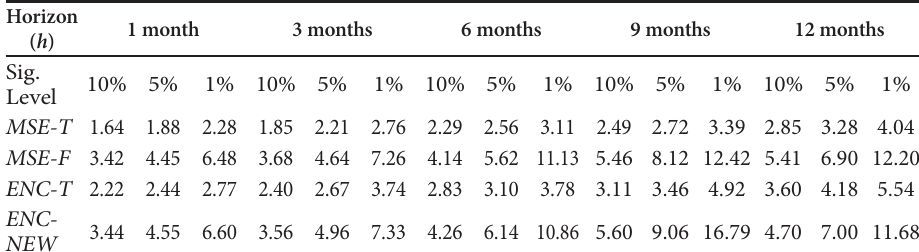
Table 3. Data-mining-robust boot strap critical values for the maximal out-of-sample statistic Hori zon ( h